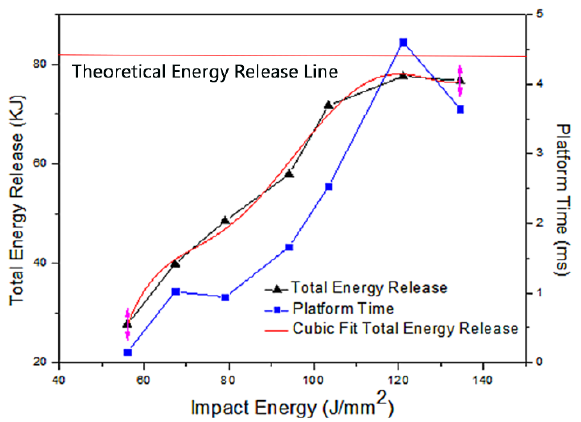
Figure 18. The relationship between the impact energy and energy release and platform time.